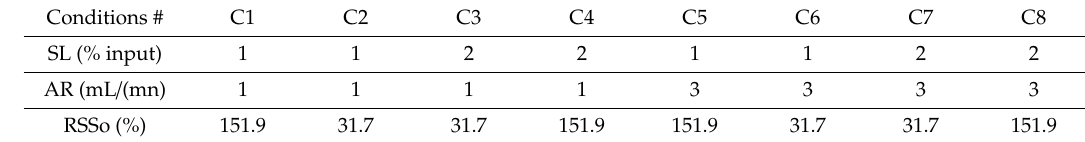
Table 2. Parameters used for computation.